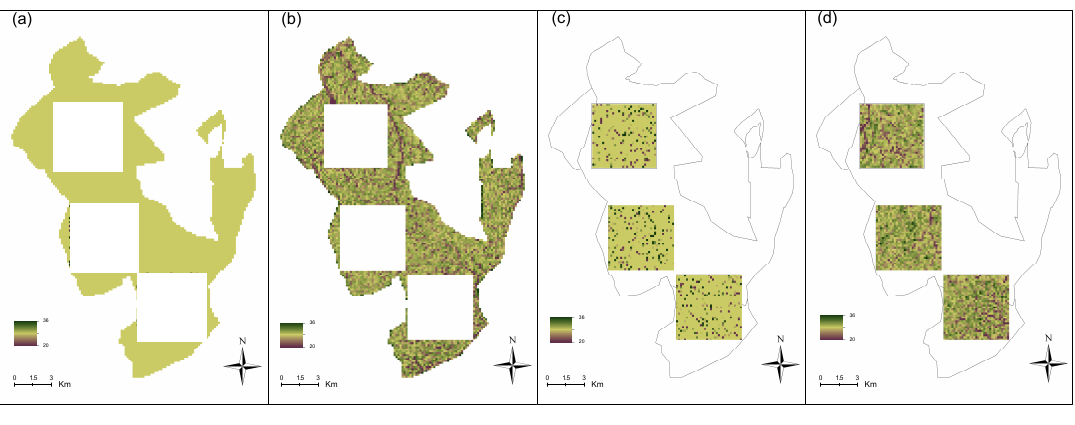
Figure 6. ( a ) DCM map derived from Kriging method outside plots without environment; the canopy height is equal to the average predicted values; ( b ) DCM map derived from Kriging method outside plots with environment; ( c ) DCM predicted with Kriging method inside plots without environment; ( d ) DCM predicted with Kriging method inside plots with